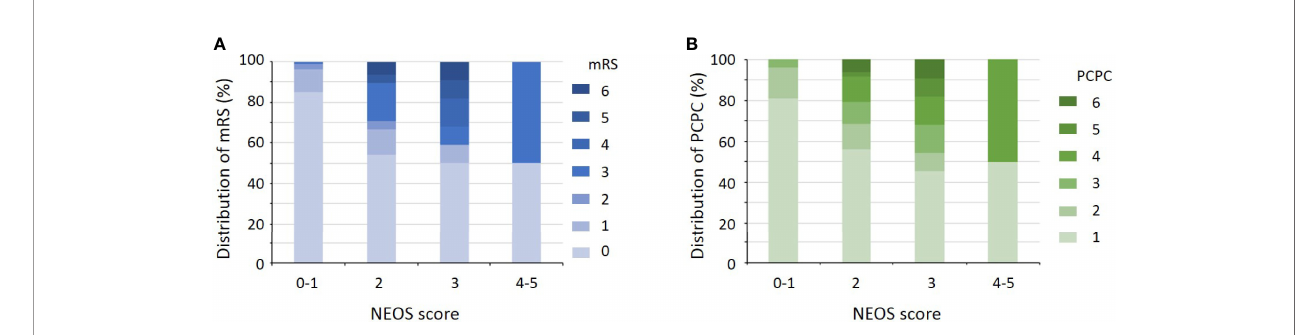
FIGURE 1 | Distribution of the mRS (A) and PCPC scale (B) across the NEOS